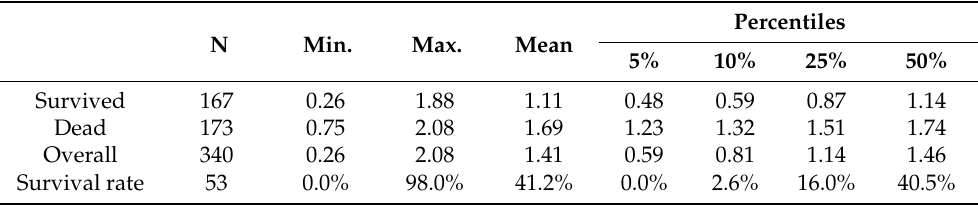
Table 1. The rhizosphere salinity of surviving or dead tall wheatgrass plants grown in saline-alkaline soils as measured with an activity meter (AM) PNT3000. The AM mean activity values are in g L − 1 . N Min.